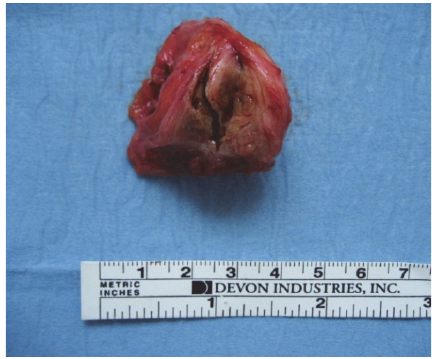
Figure 3: Removed surgical specimen of rectus abdominis endo- metrioma.